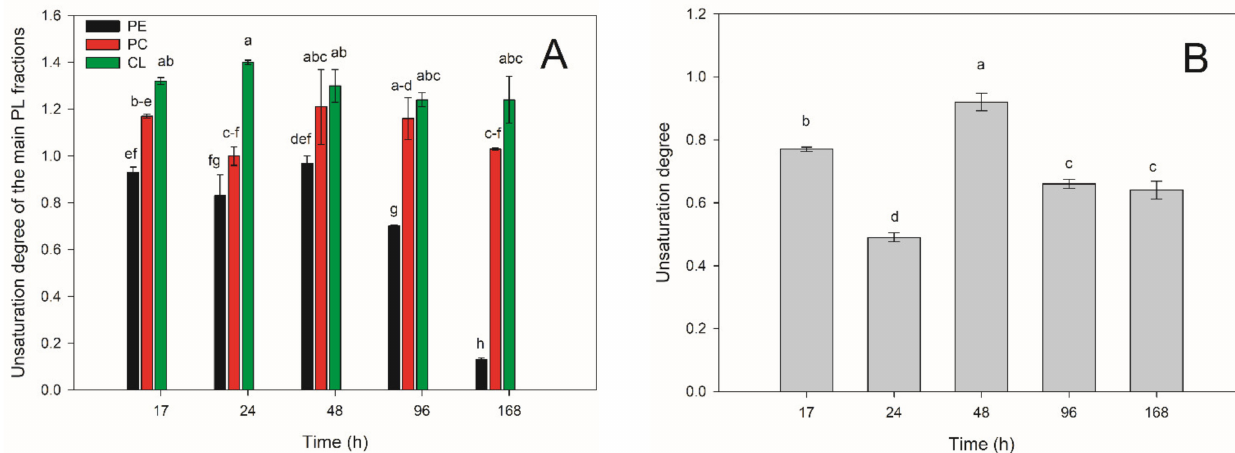
Figure 5. The unsaturation degree of the E.magnusii mitochondria from the cells raised in different growth phases ( B ). The unsaturation degree in the main PLs fractions of the E. magnusii mitochondria from the cells raised in different growth phases ( A ); PE— phosphatidylethanolamines; PC—phosphatidylcholines; CL—cardiolipins. a–h Means with the same letter did not differ significantly. Values are mean ± S.E.M from three independent experiments and three analytical induction